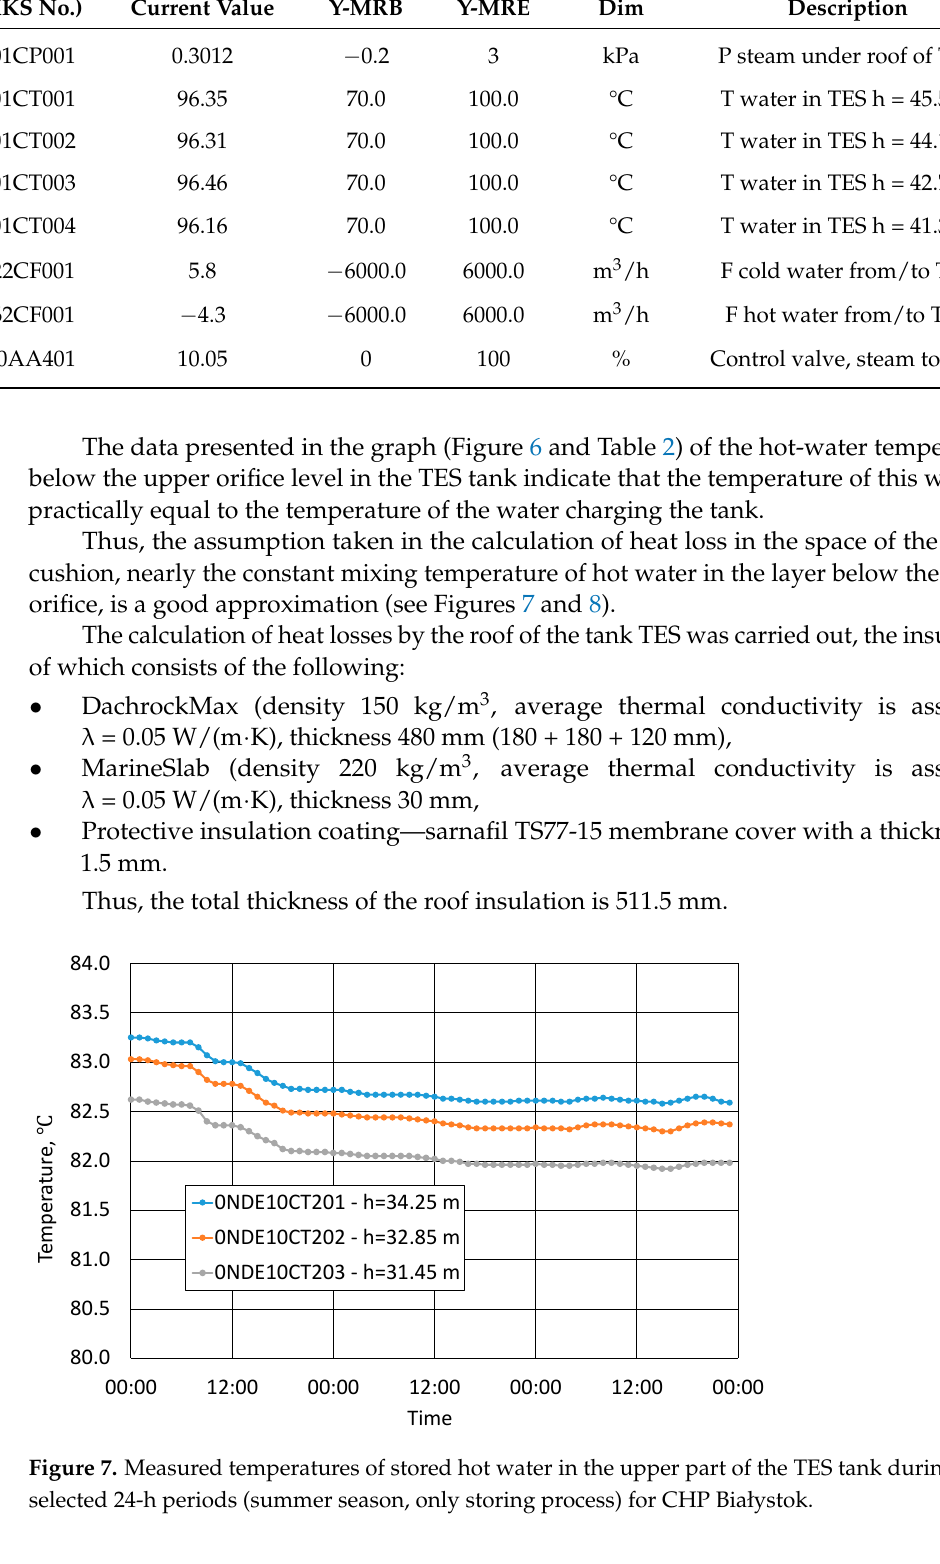
Table 2. Description of the signals (pressures, temperatures and flow rates) for 2.5 months’ operational data. No. Mark Signal (KKS No.) Current Value